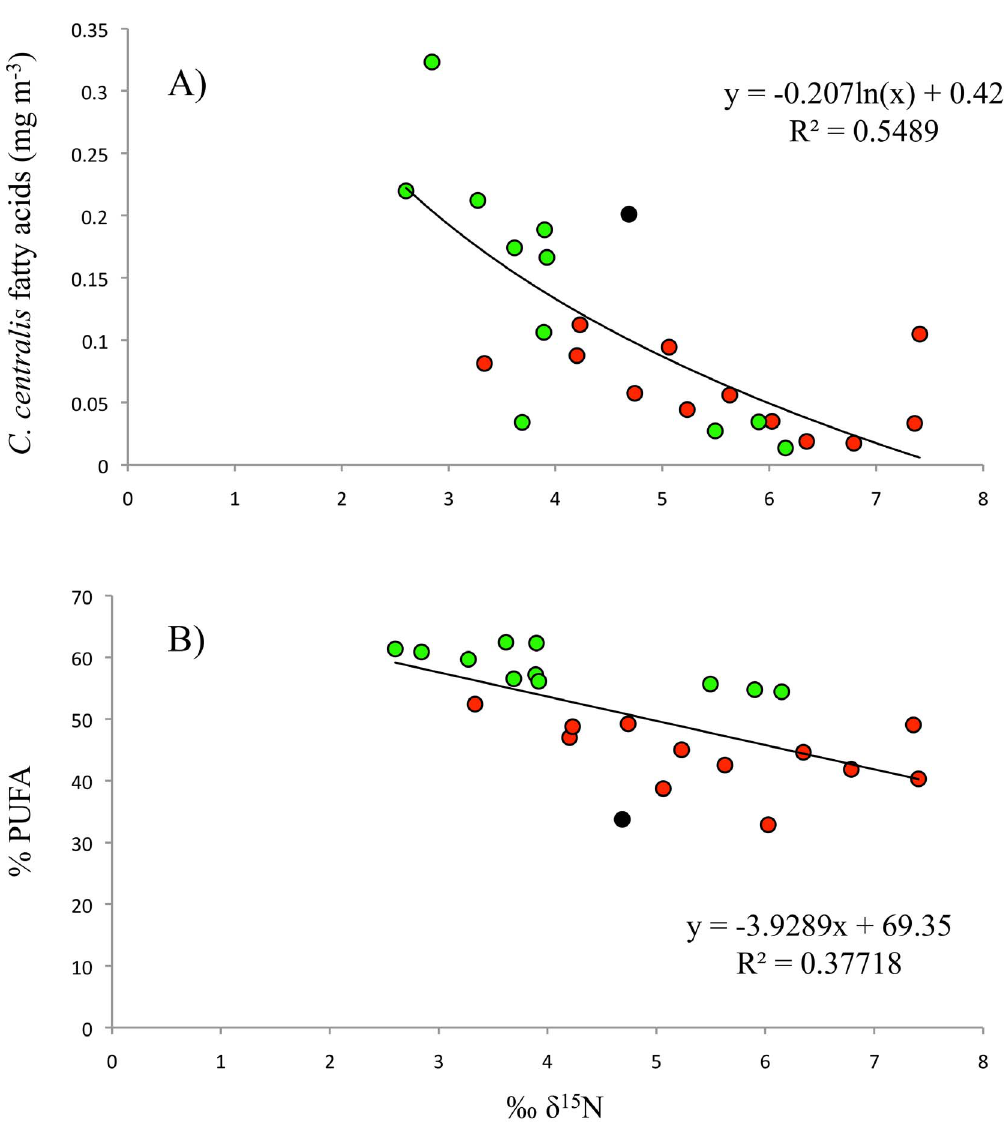
Figure 5. Relationship between d 15 N and A) concentrations (mg m 2 3 ) of C. centralis fatty acids in the water column and B) PUFA (%) of C. centralis. Colours correspond to the clusters identified in Fig. 4; black indicates cluster 1, red is cluster 2 and green is cluster